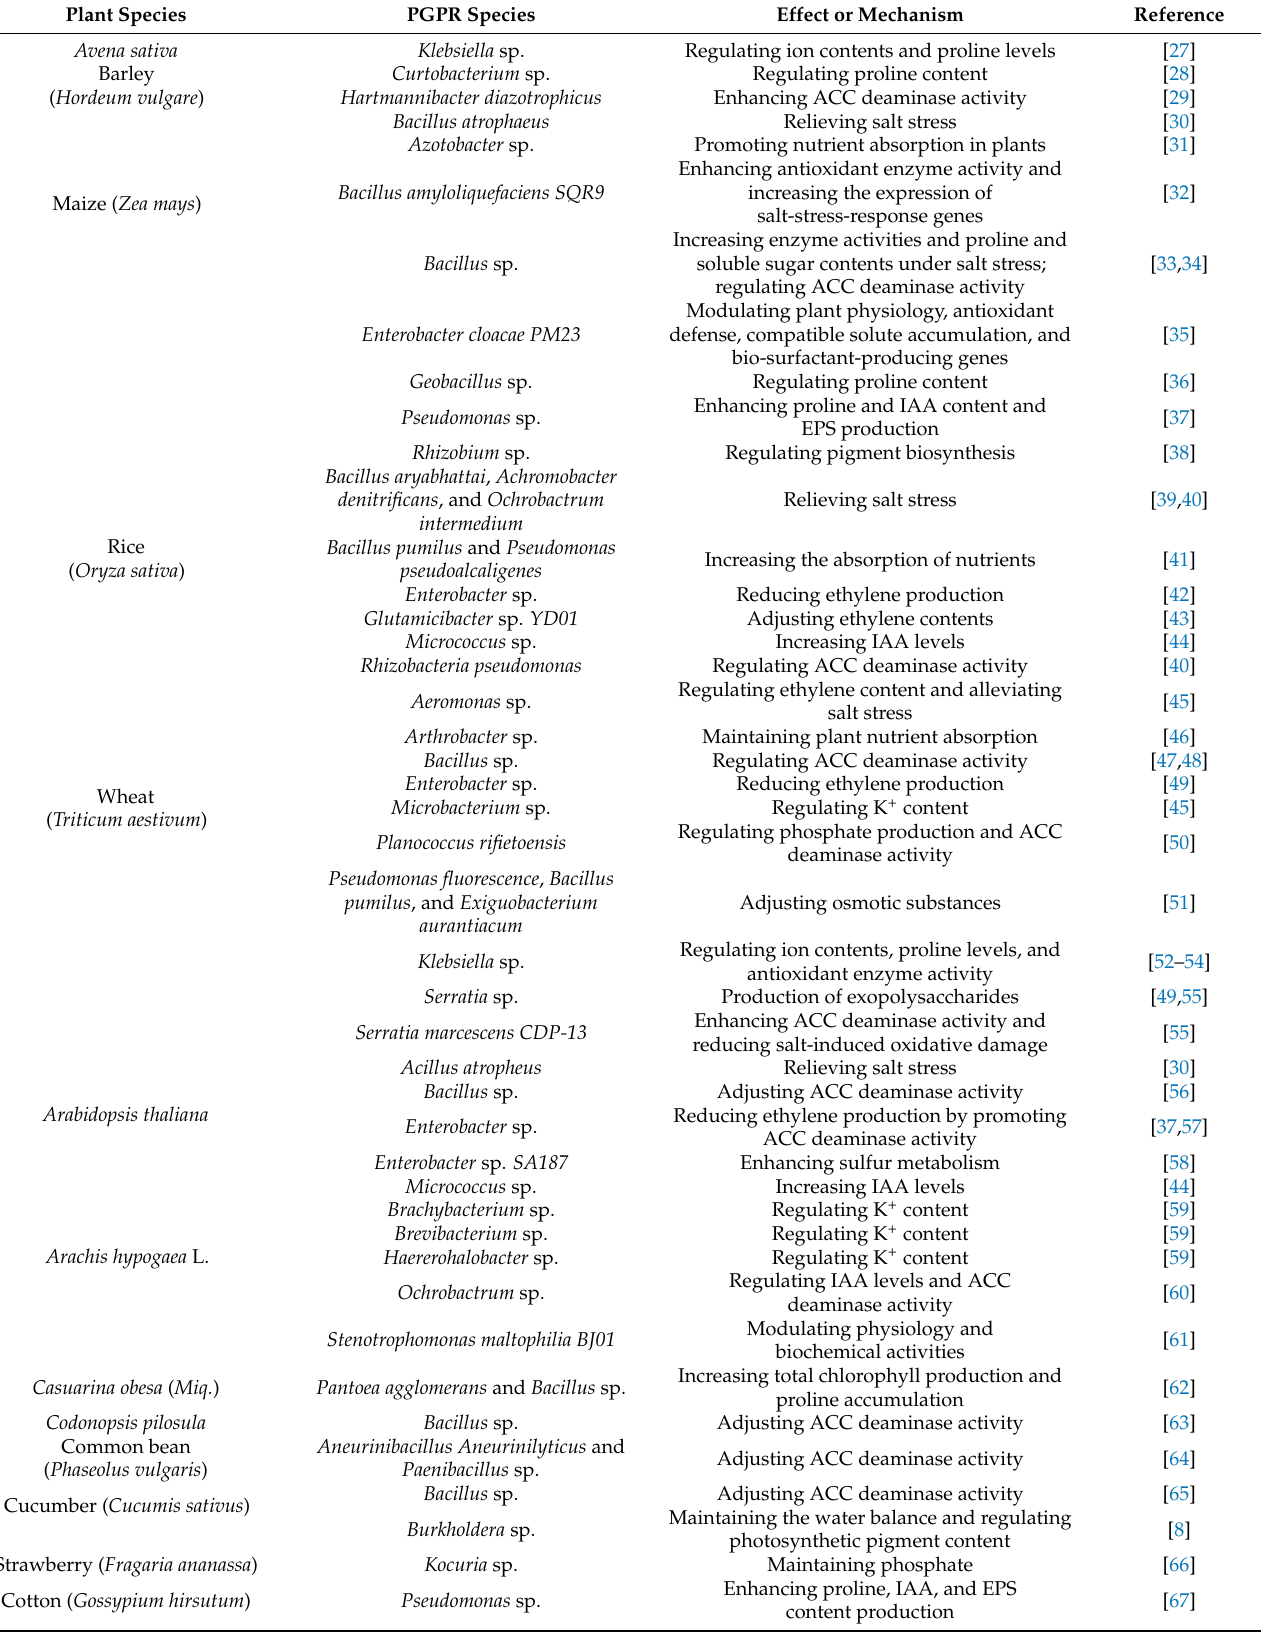
Table 1. Interaction of plant growth-promoting bacteria (PGPR) under stress and their beneficial